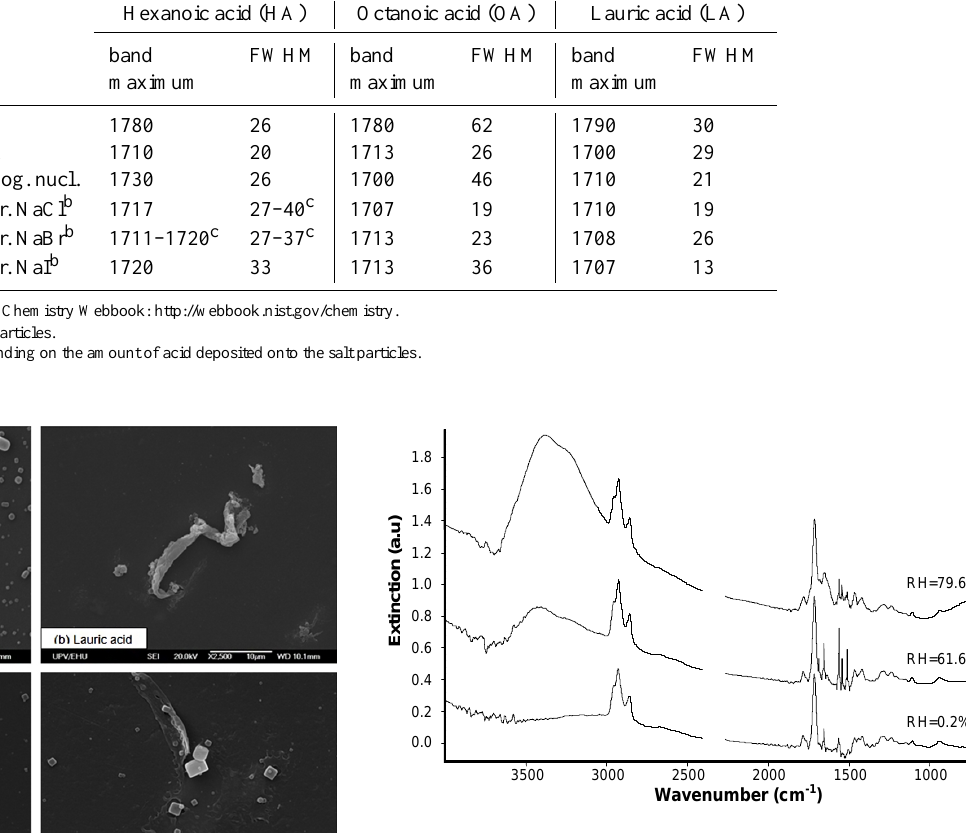
Figure 5. Infrared spectra of NaBr particles after passing through the heated reservoir containing OA and exposed to different